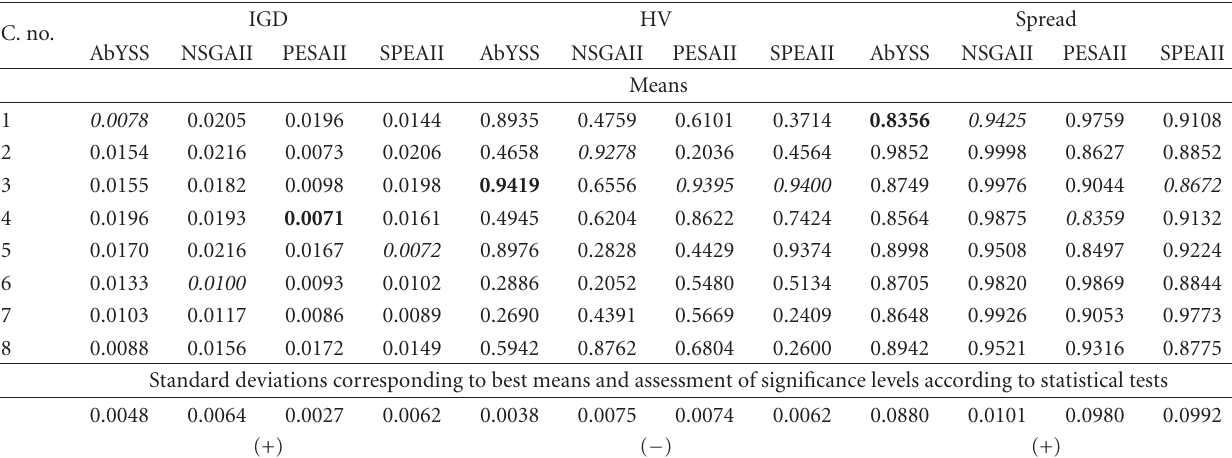
Table 5: Values of measurement quantities obtained by “Eval. Number = 5,000” and “Pop. Size = 100” for design example 2. IGD HV Spread C. no. AbYSS